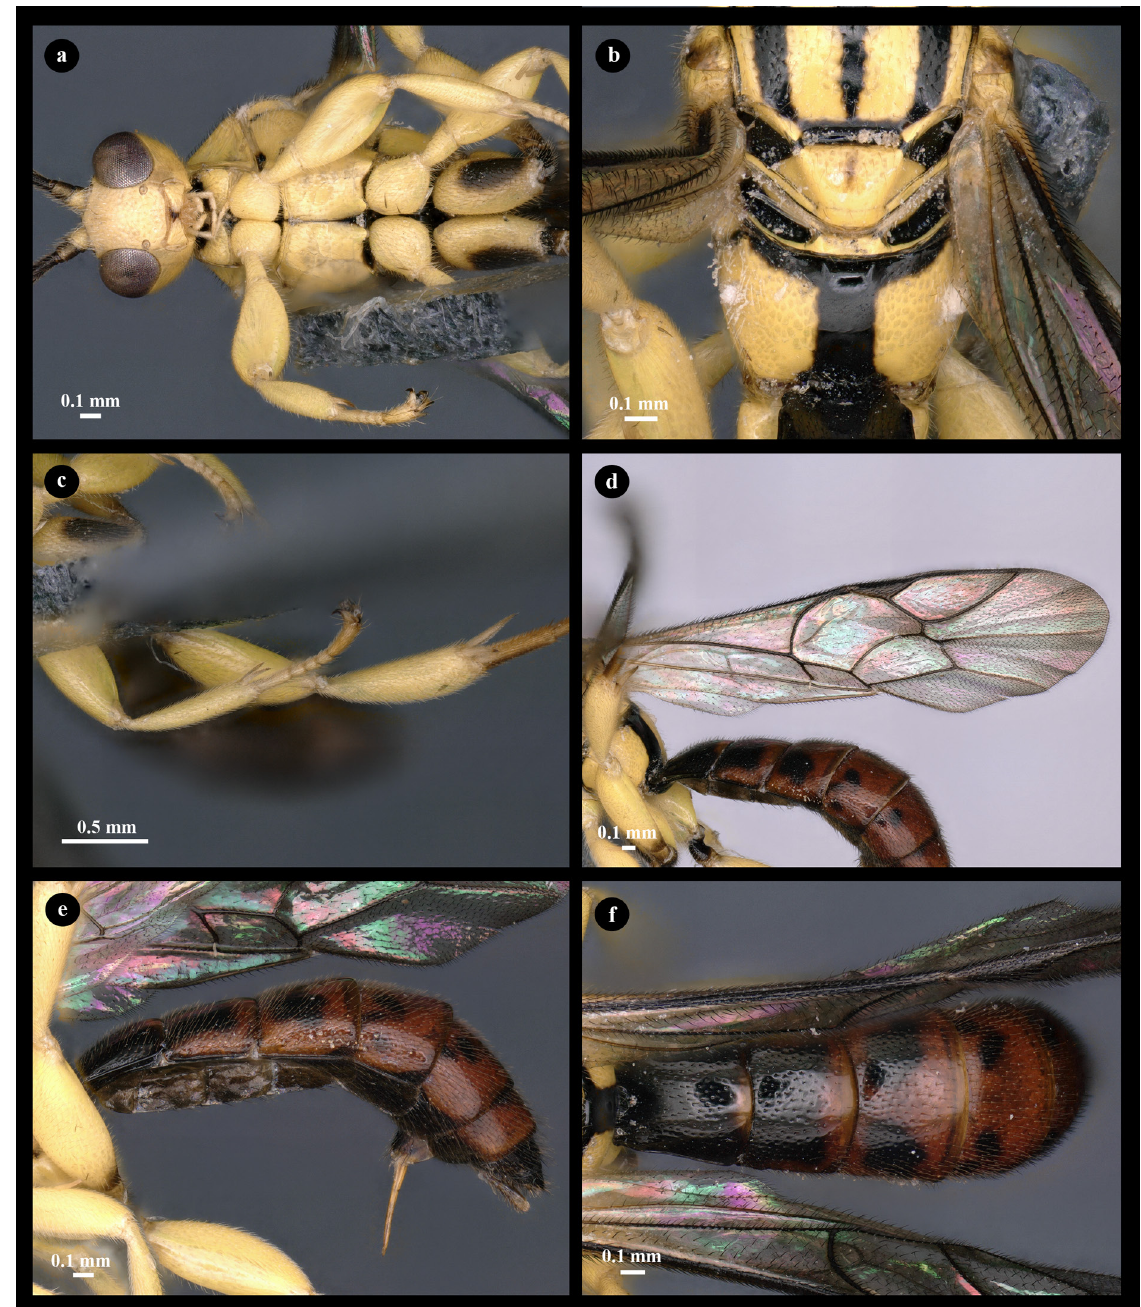
Fig. 18. Soliga ecarinata gen. et sp. nov., holotype, ♀ (AIMB). a . Head and mesosoma, ventral view. b . Propodeum, dorsal view. c . Fore and mid legs. d . Fore wing. e . Metasoma, lateral view. f . Metasoma, dorsal